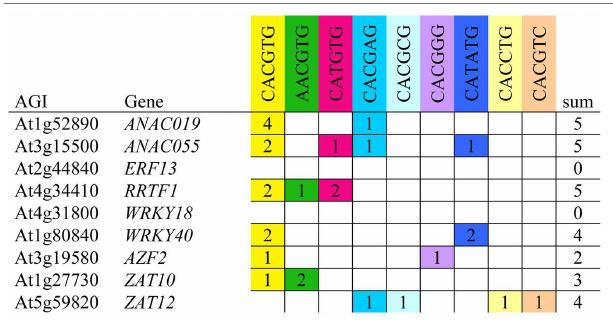
Table 3 | MYC-binding sites in the promoter of